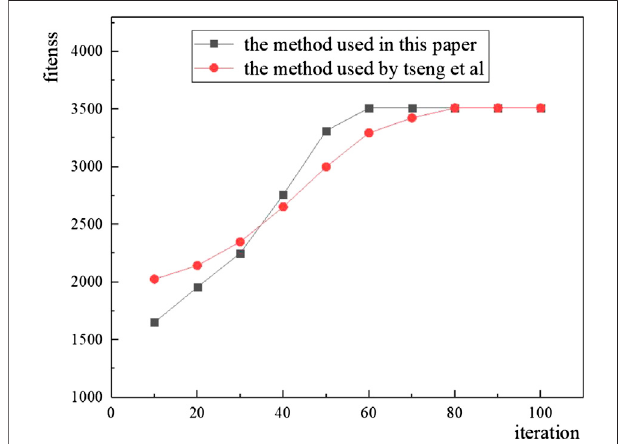
FIGURE 10 | The comparison with other